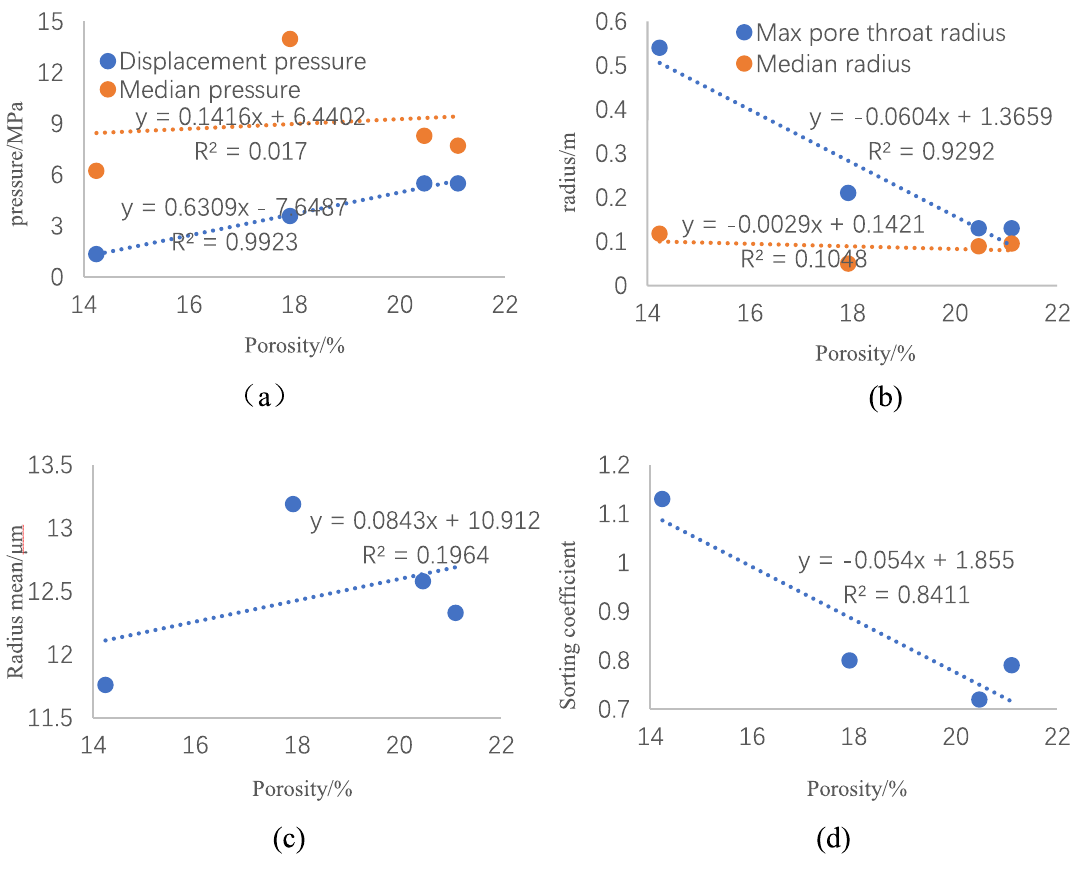
Fig. 4 Relationship between porosity and experimental results